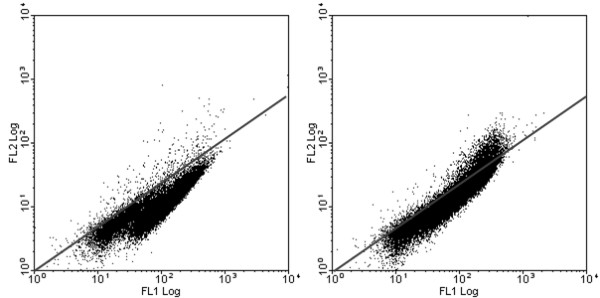
Correlation between allergenic protein expression and binding to serum IgE. Double staining of cells expressing CD20 (left) or Ves v 5 (right) with patient sera IgE and anti-C-myc antibody. The anti-C-myc binding is measured in FL1 and the IgE binding in FL2.